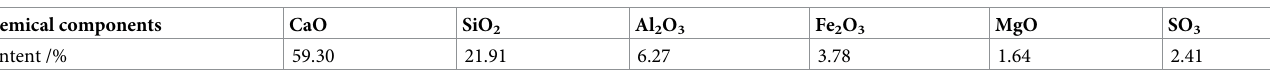
Table 1. Chemical composition of